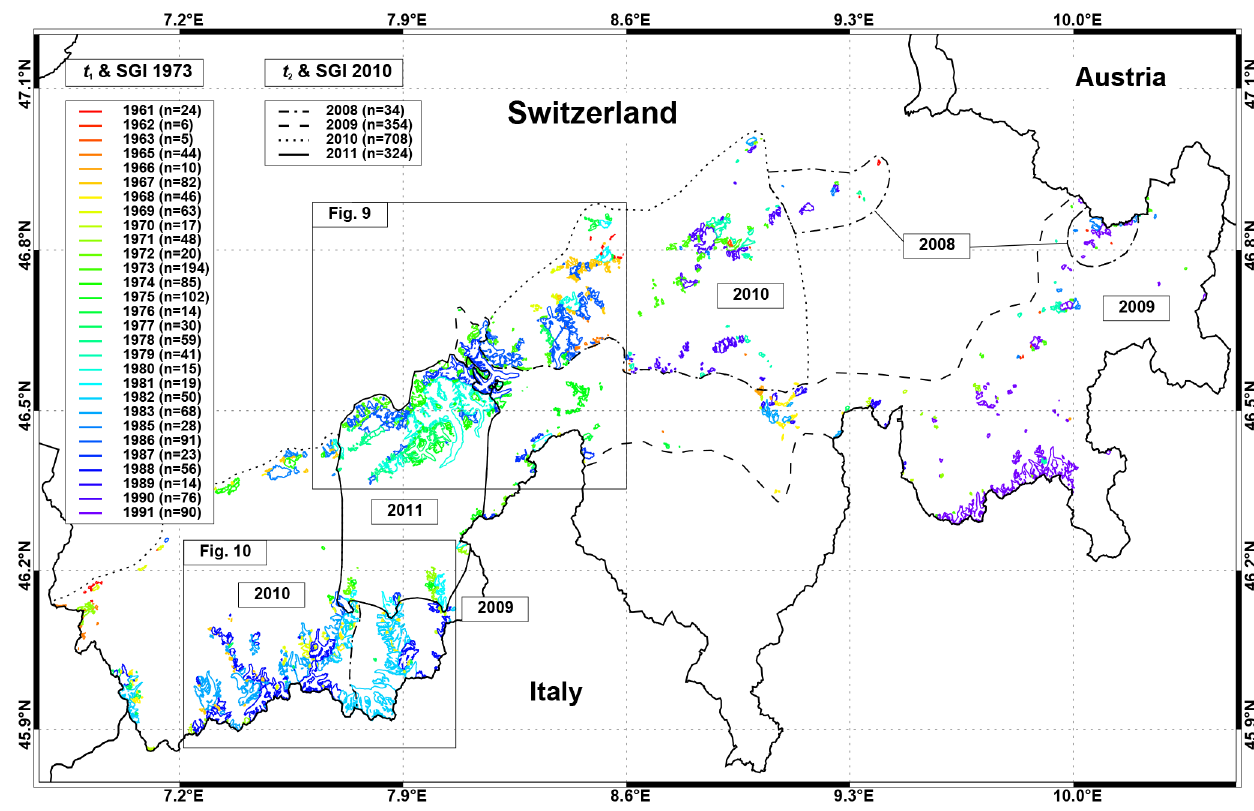
Figure 1. Glaciers in the Swiss Alps. Colours refer to the acquisition date of the elevation information (DHM25 Level 1) defining the beginning of the investigated period ( t 1 ). Black lines delimit areas of equal acquisition dates of both glacier outlines and surface topography at the end of the investigated period ( t 2 ). Two black rectangles show the perimeters of close-ups with resulting mean geodetic mass balance.